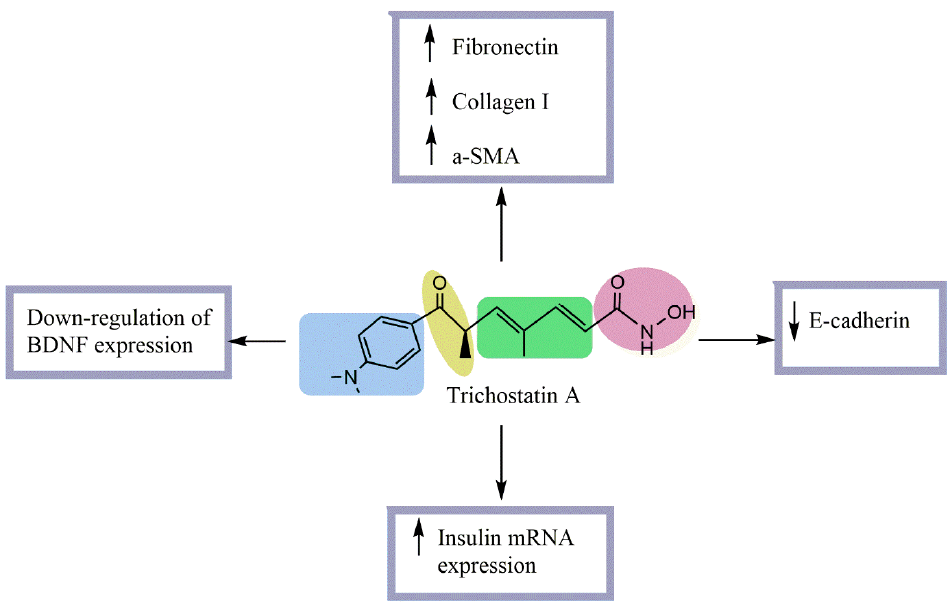
Figure 3. Antidiabetic mechanisms of TSA.